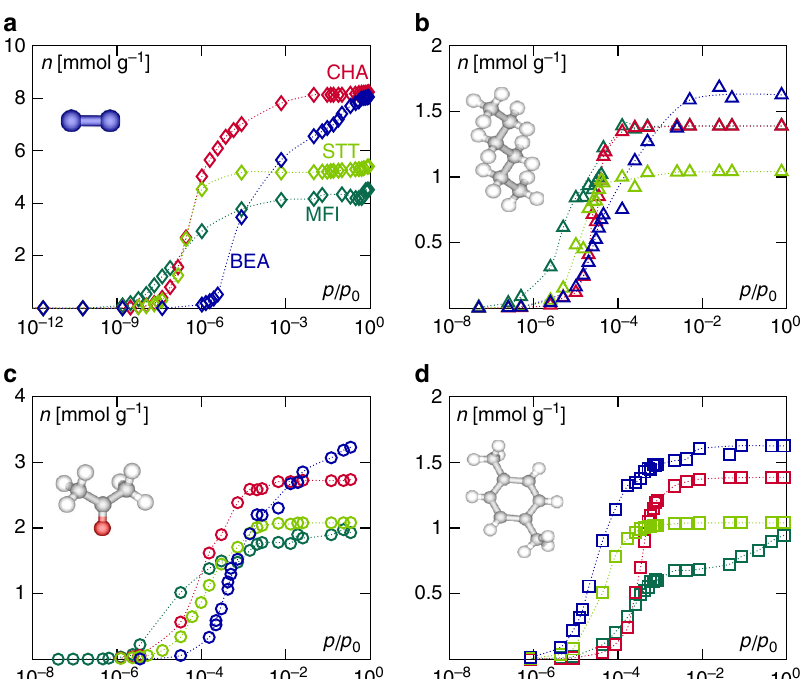
Fig. 3 Fluid adsorption in siliceous zeolites. Simulated adsorption isotherms for nitrogen at 77 K ( a ), n -hexane at 298 K ( b ), acetone at 298K ( c ), and p - xylene at 298 K ( d ) in different siliceous zeolites: silicalite-1 (MFI, ortho, dark green data), chabazite (CHA, red data), STT (light green data), and beta (*BEA, blue data). Note the use of a log scale for the abscissas which correspond to the gas pressure axis. The bulk saturating vapor pressure p 0 for each gas at the corresponding temperature is given in Supplementary Table 1